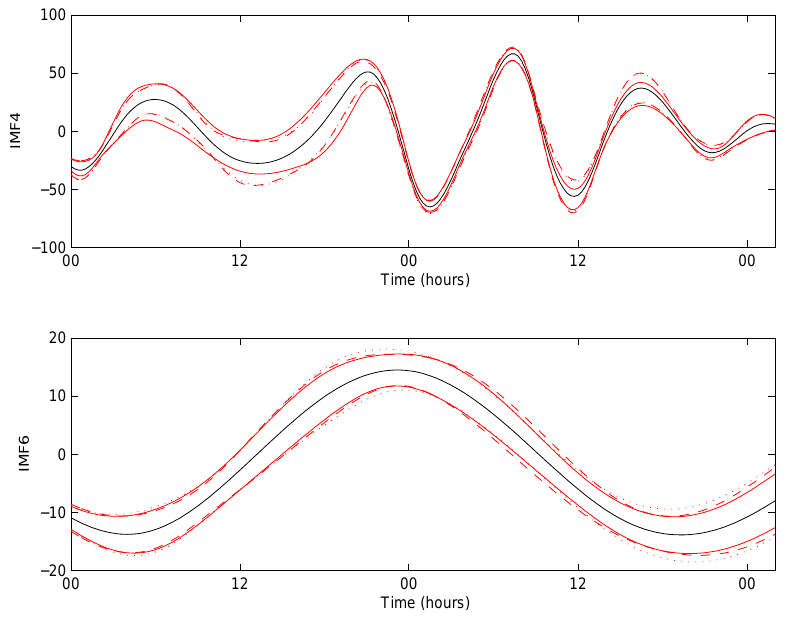
Fig. 5. The ensemble mean (black line) and the mean plus and minus the ensemble standard deviation for realizations which add 1, 2 and 5% white-noise (red full, dotted and dashed lines) for the fourth IMF (a) and the sixth IMF (b) which result from the application of the EMD technique to the zonal wind time-series observed with the Scott Base MF radar at 90km between 10 and 12 January 2006 inclusive.